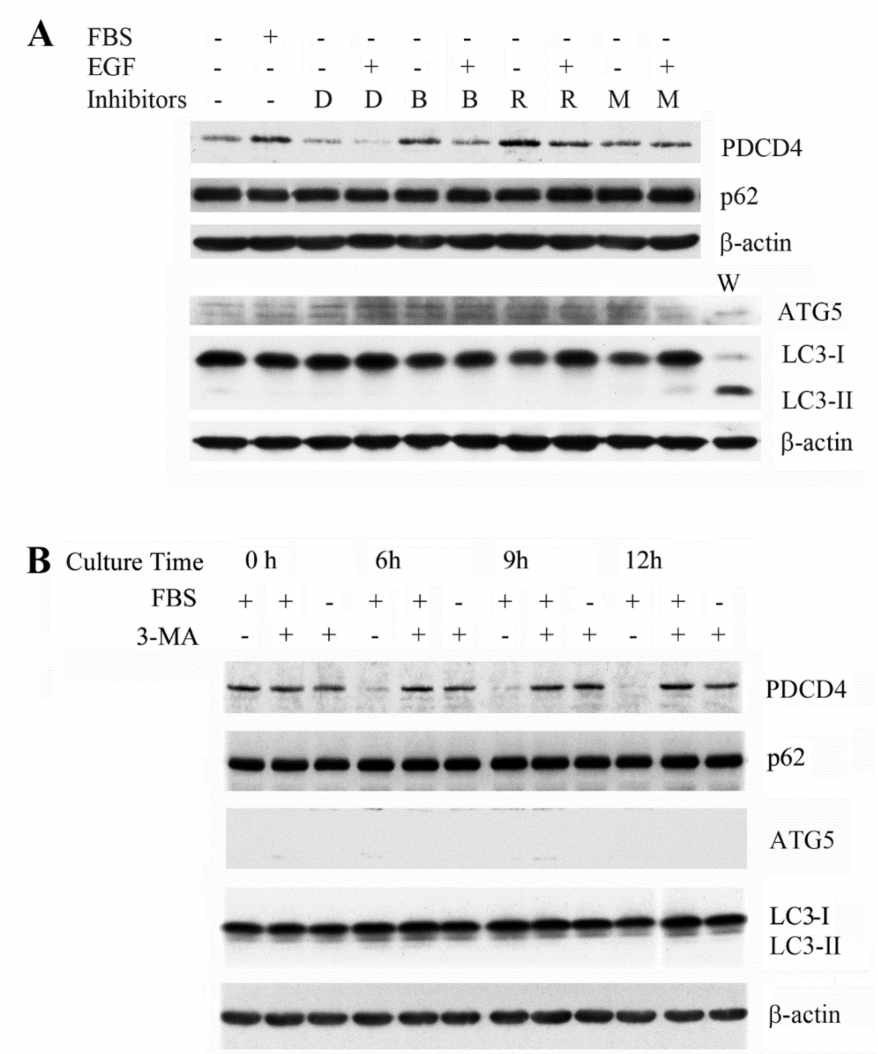
Figure 4. The PDCD4 levels were upregulated by the autophagy inhibitors bafilomycin A1 and 3-MA and by the proteasome inhibitor MG132 in ATG5 mutant cells. ( A ) After reaching 90–95% confluency, the ATG5 mutant Huh7 cells were treated with DMSO (D) as a control, 10 µ M bafilomycin A1 ( B ), 0.1 nM rapamycin (R) and 20 µ M MG132 in the presence or absence of EGF in normal or serum-free medium and incubated for 4 h. The cells were collected and Western blotting analyses were performed by using antibodies against the components mentioned in the figure. ( B ) ATG5 mutant Huh7 cells at 90–95% confluency were treated with 5 mM 3-MA and the culture continued for 6, 9, and 12 h, after that cells were collected for Western blotting. Experiments were repeated at least three times and similar results were obtained. The representative results are